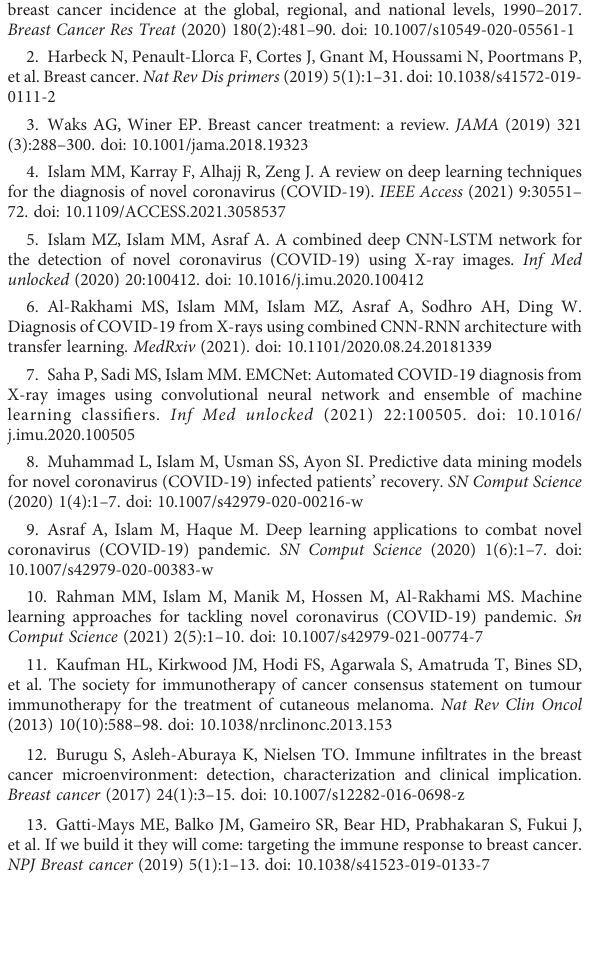
SUPPLEMENTARY TABLE 1 Different expression genes between tumor and normal with |LogFC| > 4, and p adjust less than 0.01. SUPPLEMENTARY TABLE 2 The results of Lasso regression. SUPPLEMENTARY TABLE 3 Univariate Cox regression for immune regulation